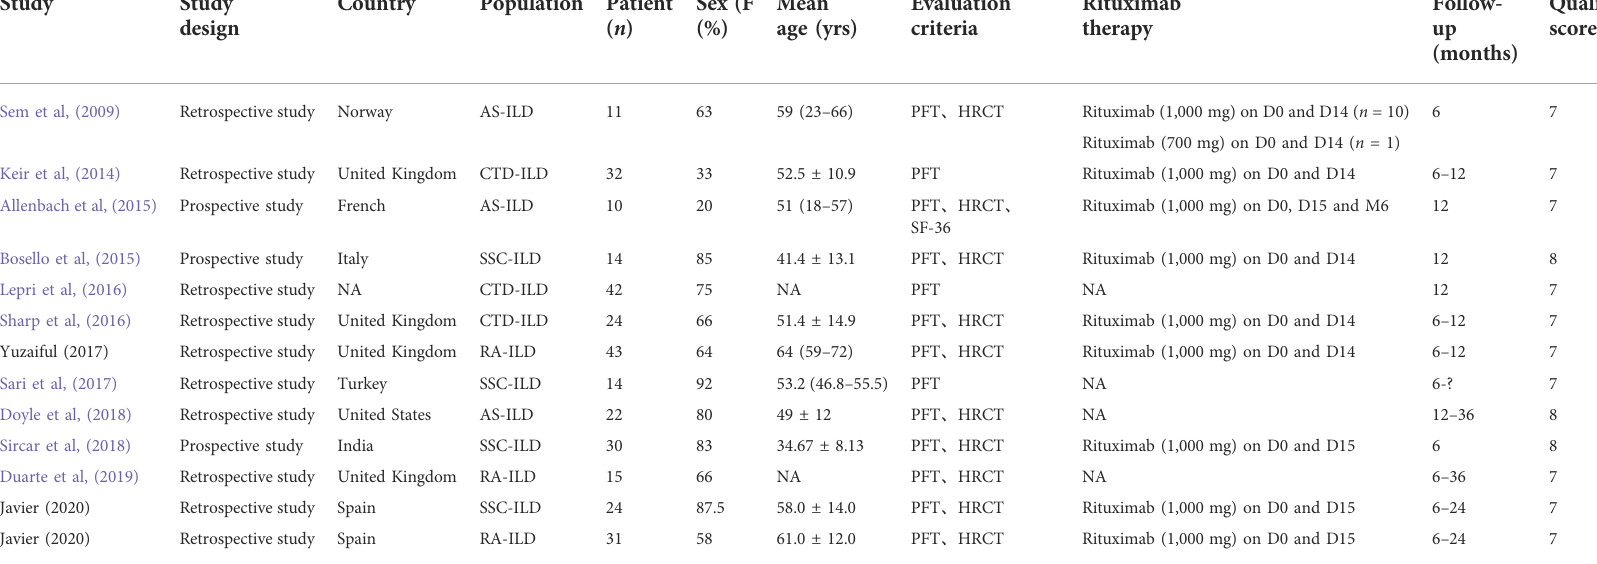
TABLE 1 Baseline clinical characteristics of included